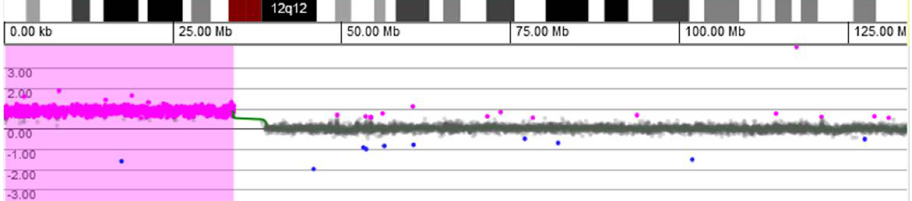
Figure 2. Array CGH result for patient 1—DNA extracted from a buccal swab.